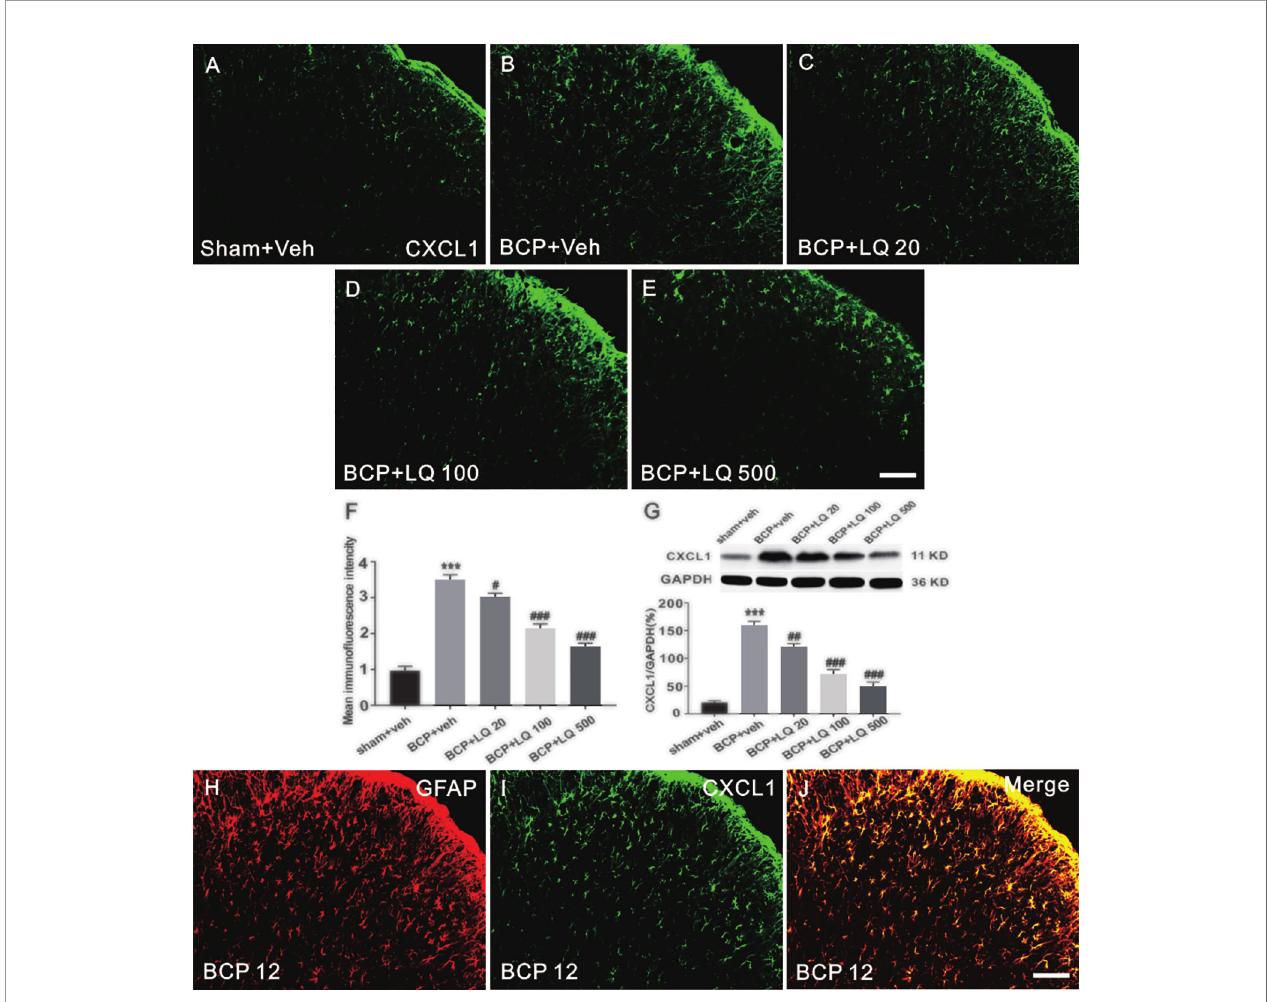
FIGURE 5 | Effects of intrathecal injection of Liquiritin (LQ) on bone cancer pain (BCP)-induced CXCL1 upregulation in spinal astrocytes. (A – E) BCP induced a remarkable upregulation of CXCL1 in the ipsilateral spinal dorsal horn. Intrathecal LQ administration inhibited BCP-induced increase in CXCL1 immunoreactivity in the spinal cord. Scale bar 100 m m; mean immuno fl uorescence intensity (F) and western blot (G) of CXCL1 expressions after different treatments (F 4,15 = 82.27, ***P < 0.001 vs. sham + Veh group; # P < 0.05, ### P < 0.001 vs. BCP + Veh group; F 4,15 = 79.38, ***P < 0.001 vs. sham + Veh group; ## P < 0.01, ### P < 0.001 vs. BCP + Veh group; n = 4, one way ANOVA, F, G ). (H – J) Immunostaining images demonstrated CXCL1(green) was predominantly co-localized with GFAP (red) as shown by overlapped staining (the rightmost panel, yellow). Scale bar, 100 m